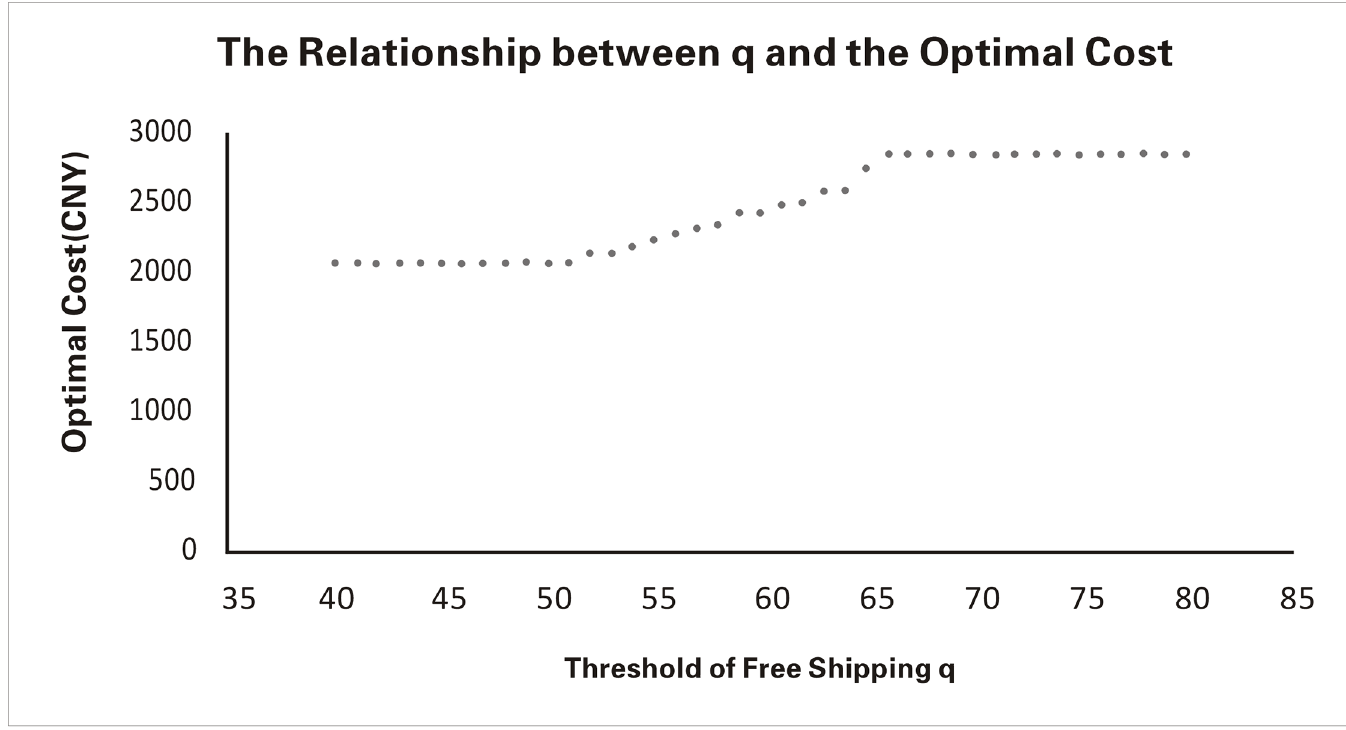
Fig 1. The Detailed Relationship between the Threshold and the Optimal